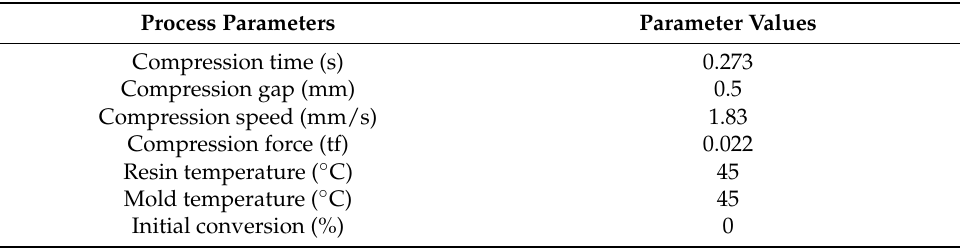
Table 4. The parameters of the dipping